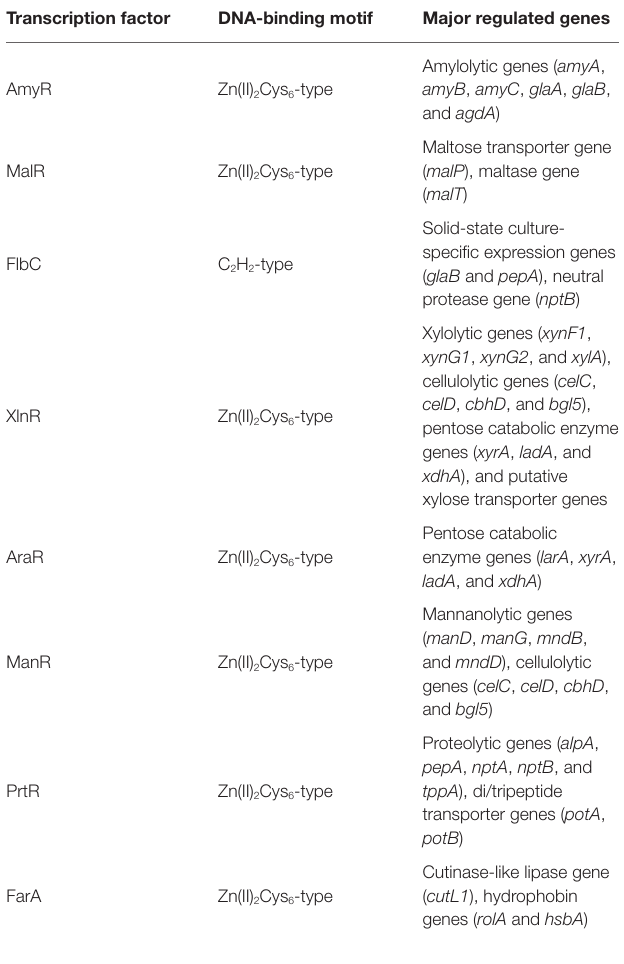
TABLE 1 | Transcription factors involved in induction of hydrolytic gene expression in Aspergillus oryzae